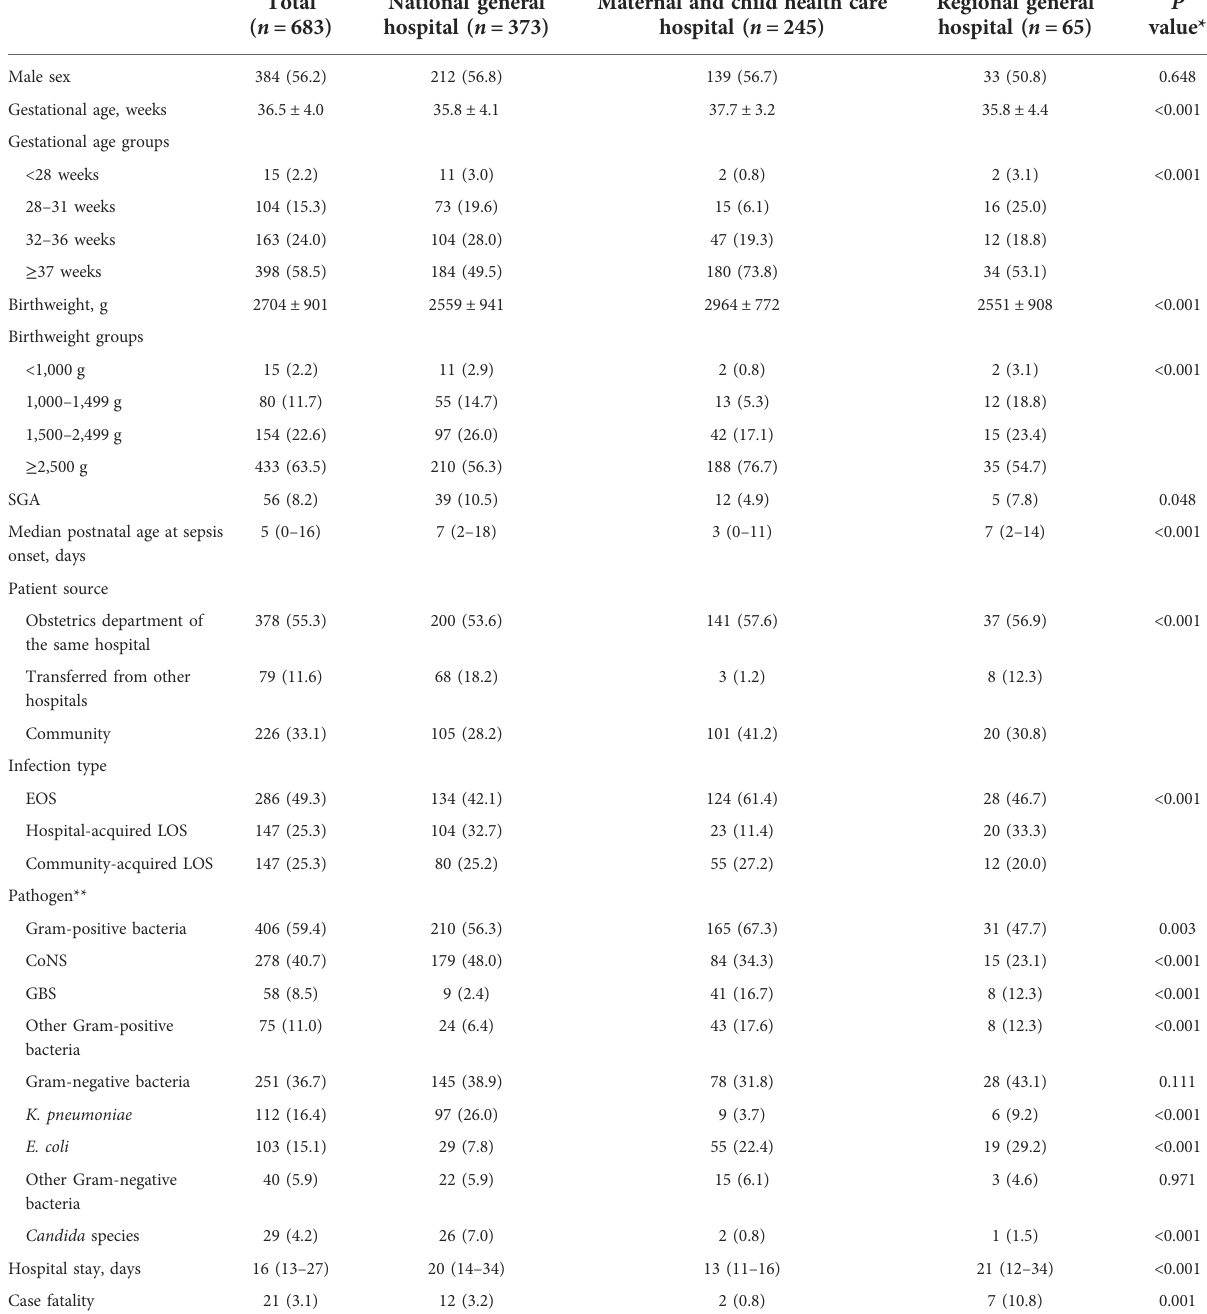
TABLE 4 Baseline demographic and clinical characteristics of neonates with culture-proven